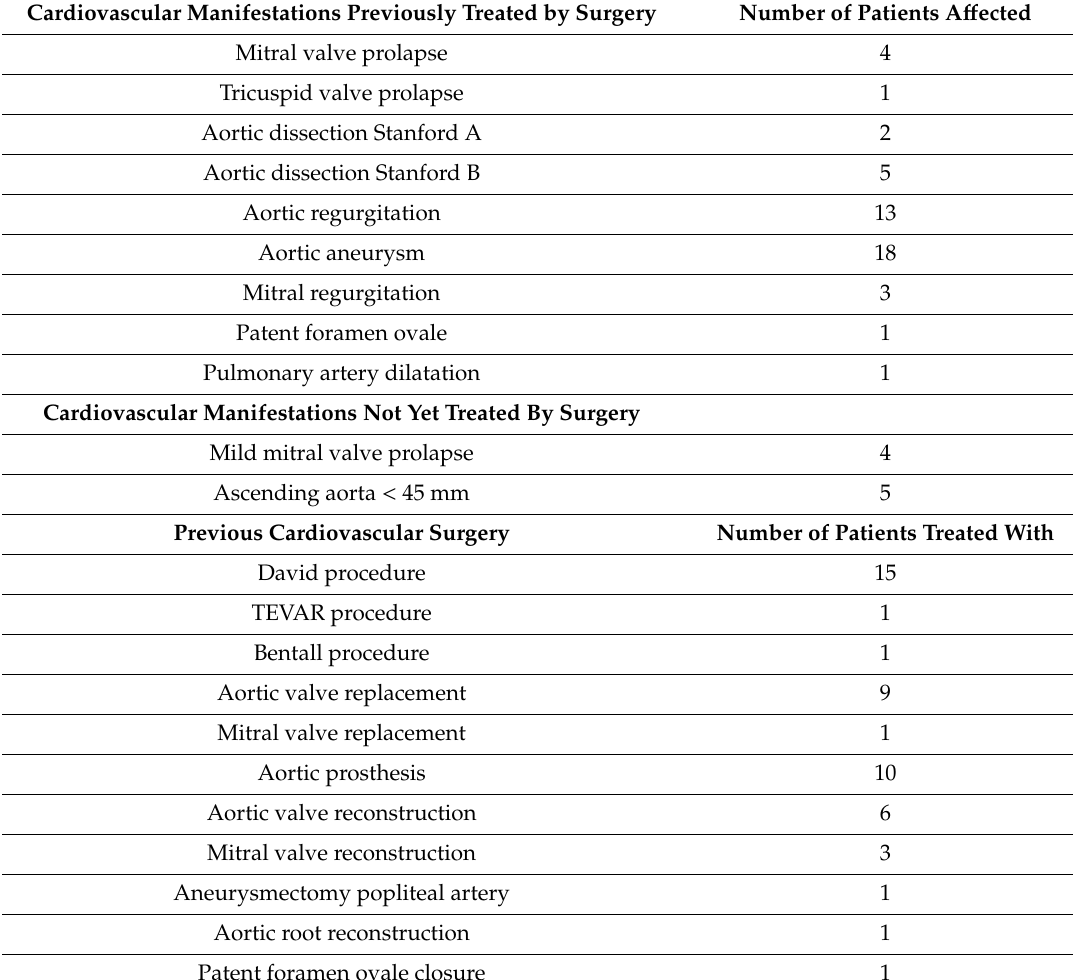
Table 3. Cardiovascular manifestations and surgical / pharmacological